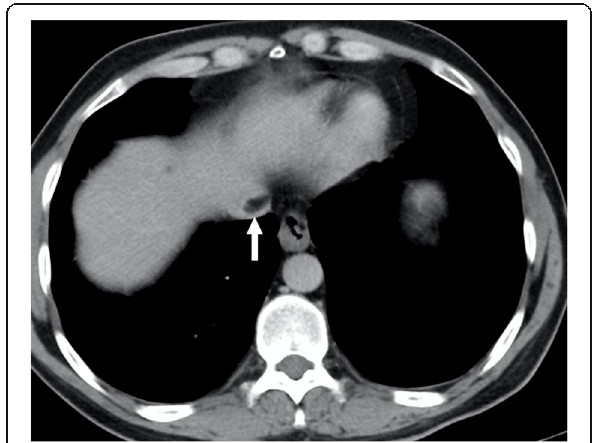
Fig. 10 A 40-year-old male with no past medical history underwent abdominal CT examination for nonspecific abdominal pain. Axial plane postcontrast CT image demonstrates protrusion of pericaval fat into the IVC lumen (arrow) mimicking an endoluminal